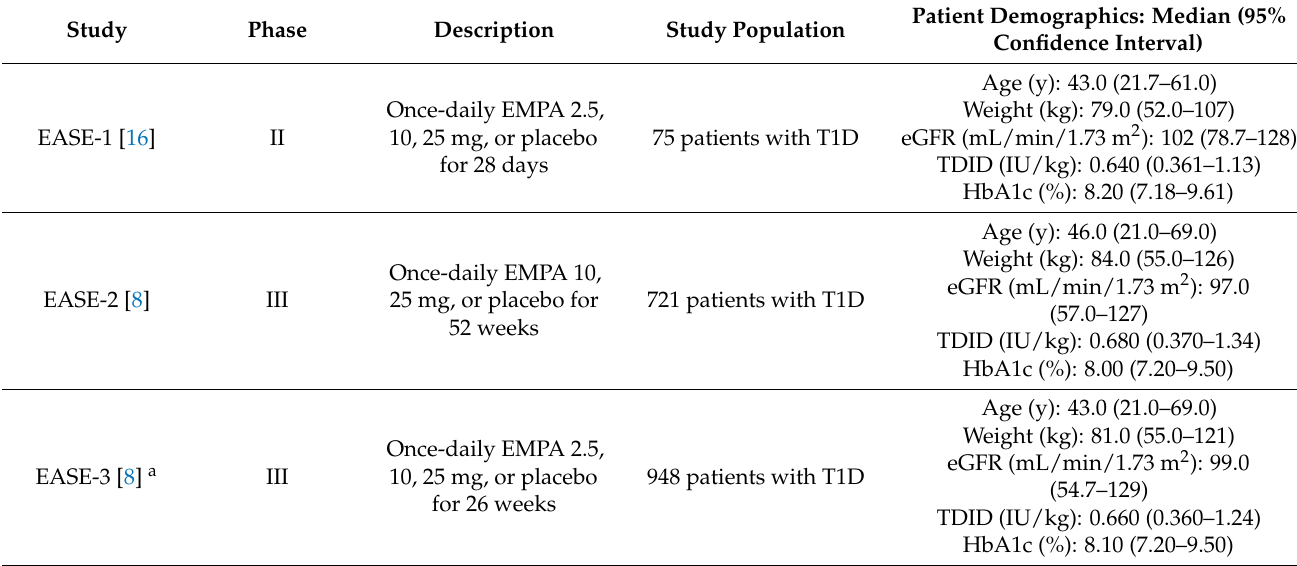
Table 1. Overview of included